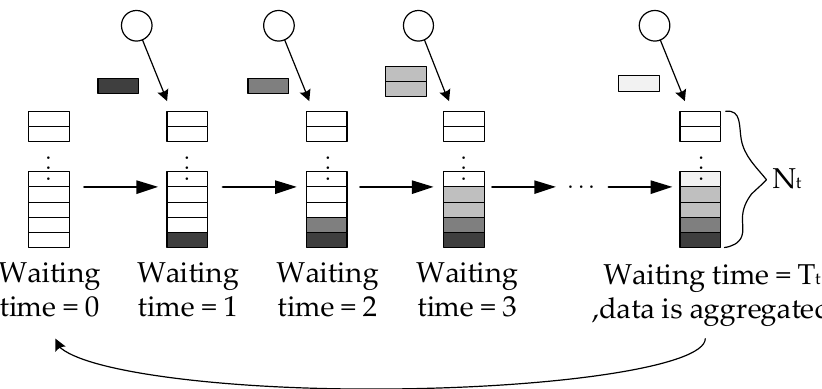
Figure 4. Packet aggregation occurs since the value of the aggregation timer is equal to T t Definition 5. Service Requirement.